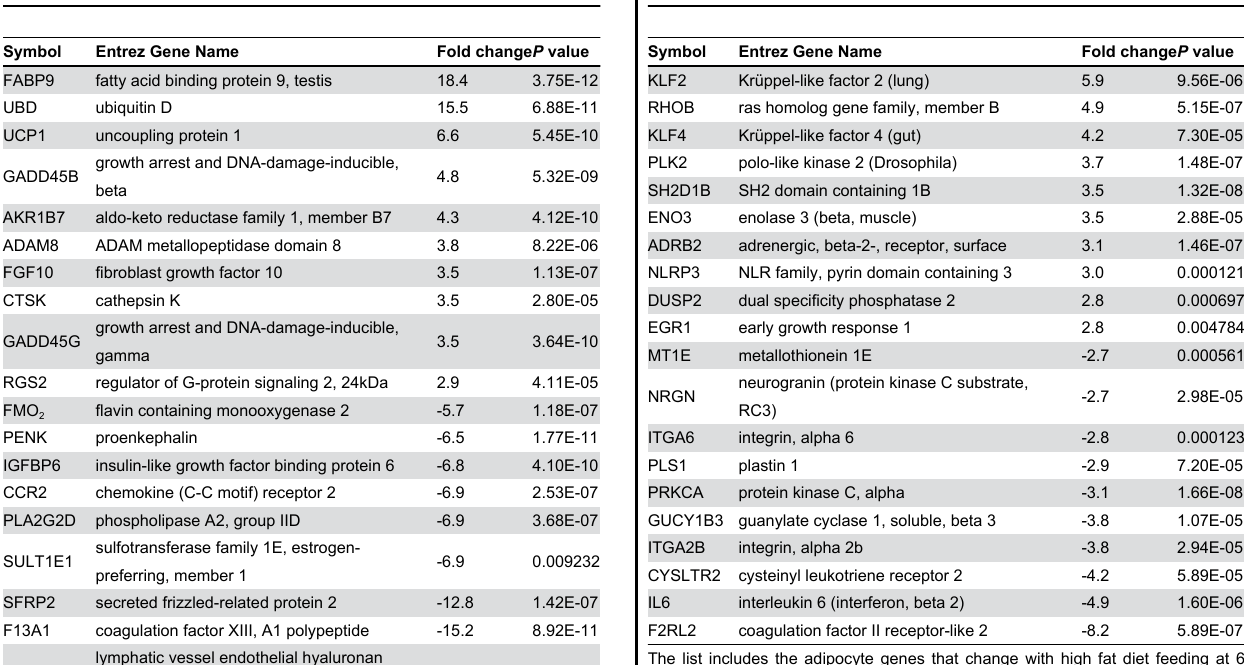
Table 4. Epididymal adipocyte genes most highly up- and down-regulated by a high fat diet at 14 months of age.